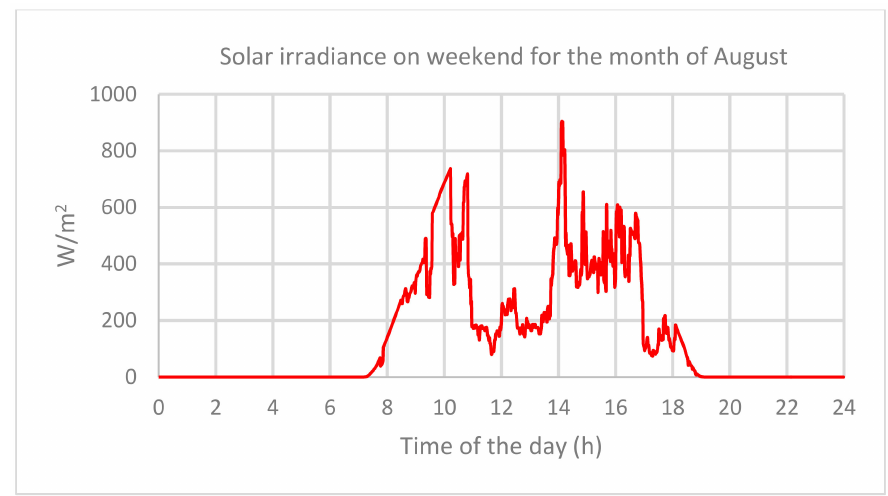
Figure 8. Irradiance on weekend for the month of August over 24 h.